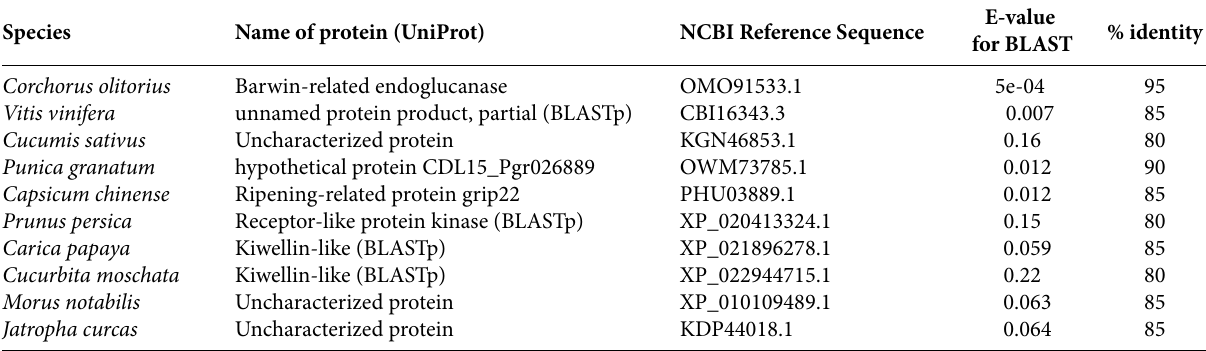
Table 2. List of kiwellin-like proteins according to the BLASTp analysis. Species Name of protein